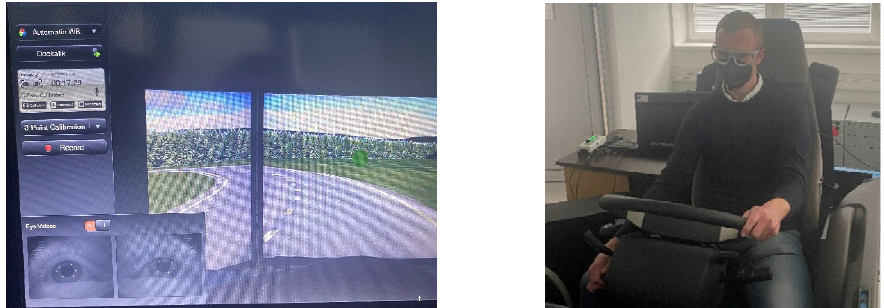
Figure 9. Eye-tracking glasses—study design. Source: own collaboration.